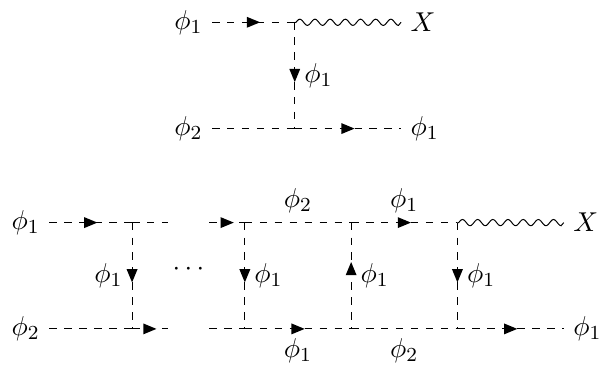
φ 1 X , at the tree level →